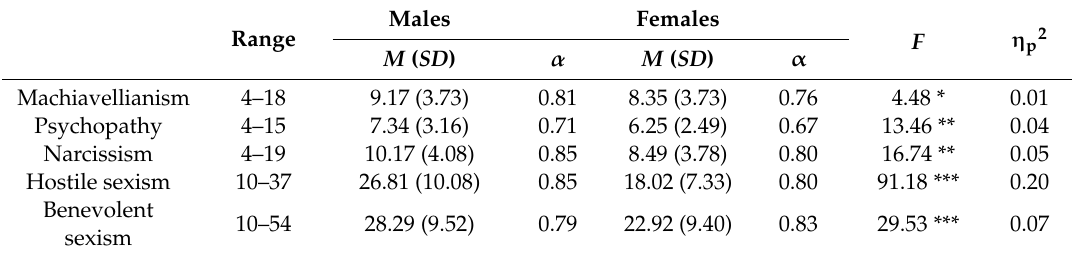
Table 1. Descriptive statistics and di ff erences among males and females in Dark Triad (DT) traits and Ambivalent